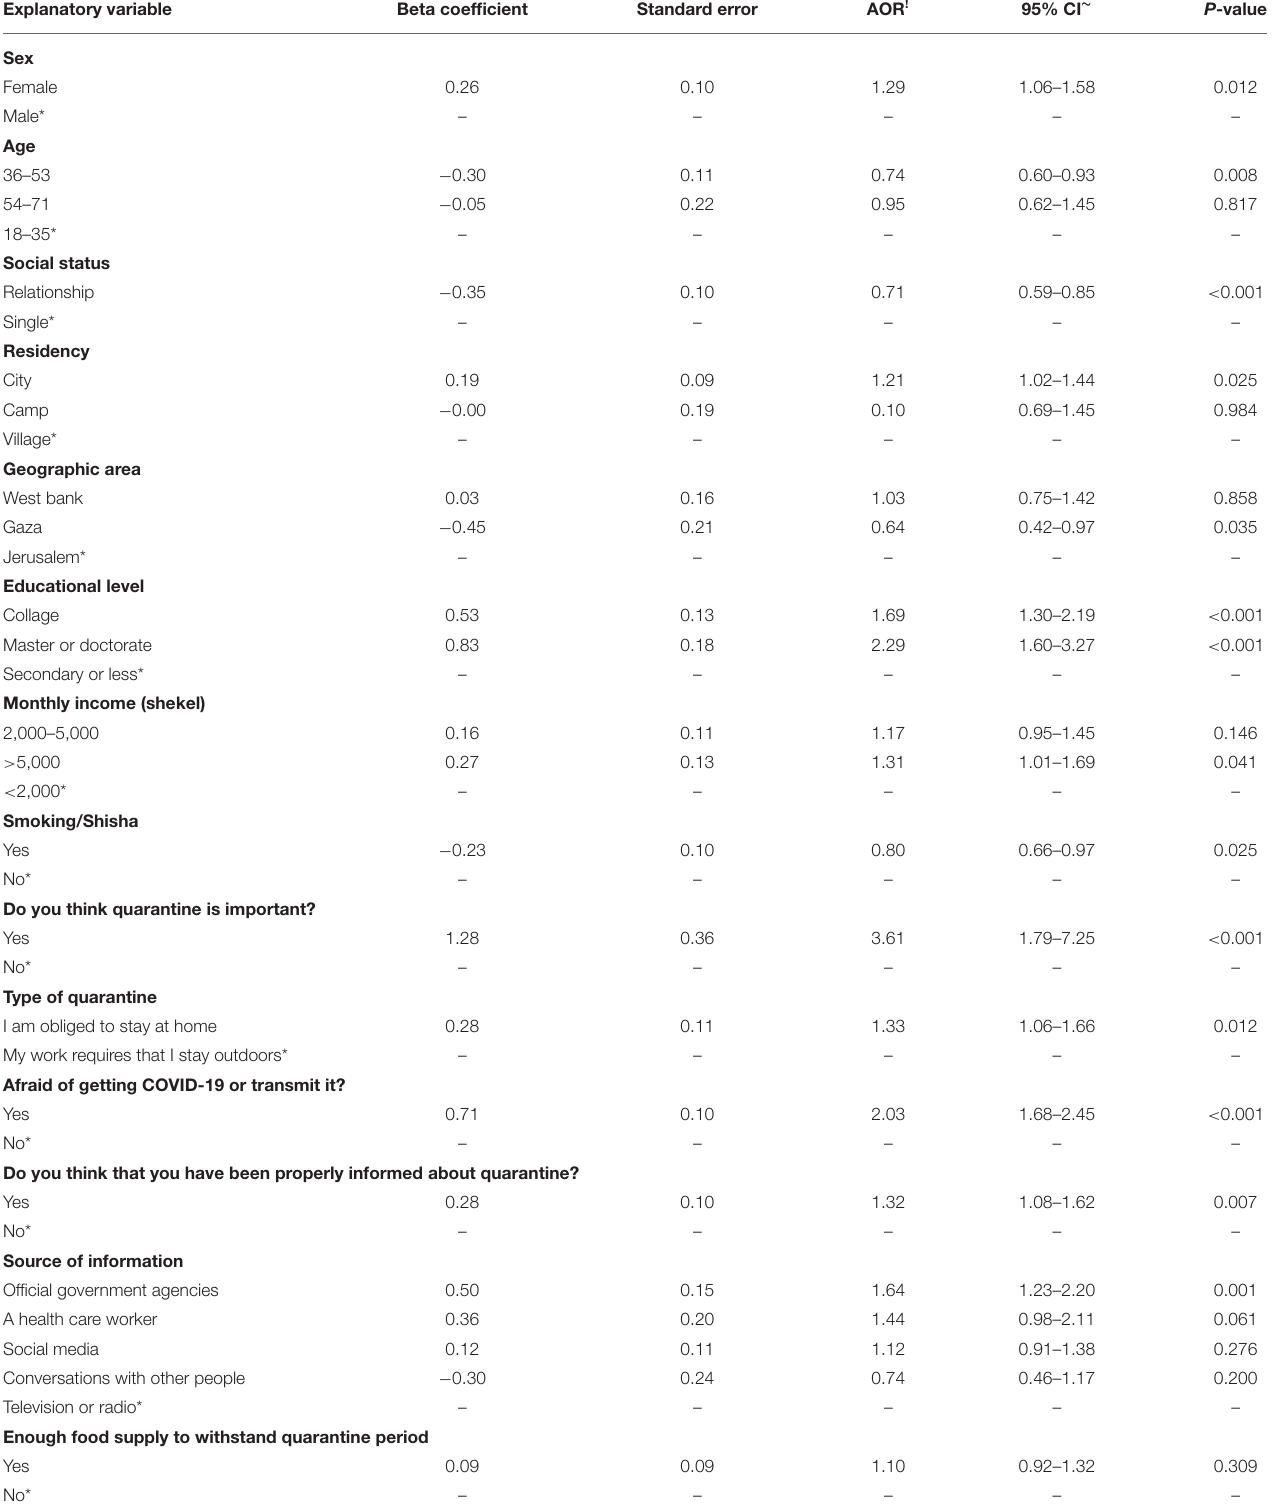
TABLE 5 | Multivariate logistic regression model for factors associated with quarantine understanding ( N =